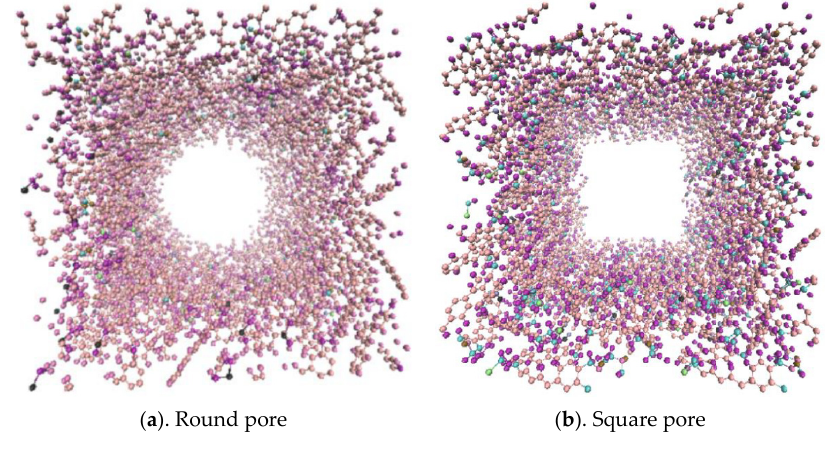
Figure 8. Different pore shape models.